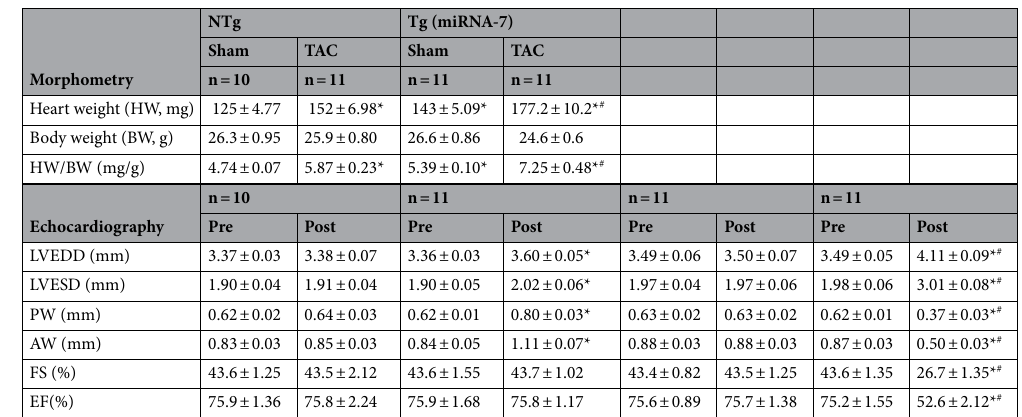
Table 2. Morphometric and echocardiographic parameter for NTg and miRNA-7 Tg mice with TAC (2 weeks). * p < 0.001 vs. Sham NTg, # p < 0.005 vs. NTg Sham & TAC and Tg Sham.